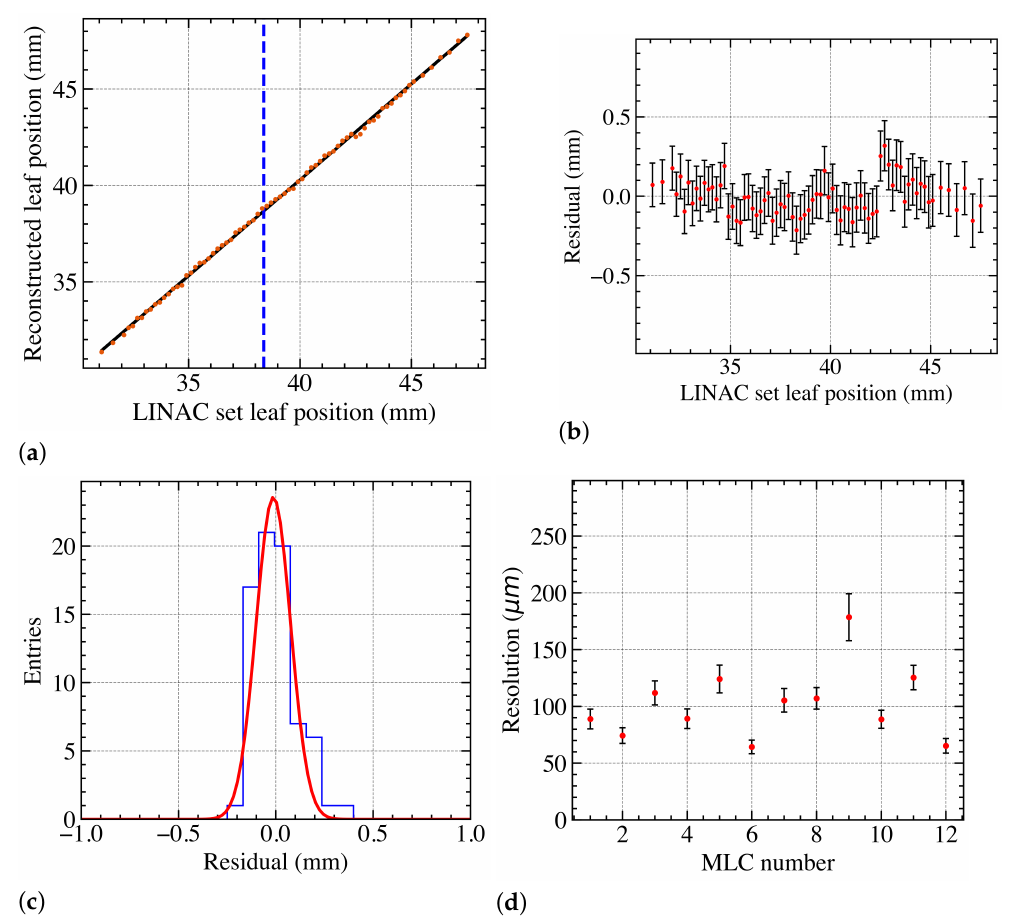
Figure 6. MLC leaf position resolution as a function of the set leaf position for leaf 1 ( a ), leaf 5 ( b ), leaf 8 ( c ) and leaf 12 ( d ) for both the Sobel and matching index methods.